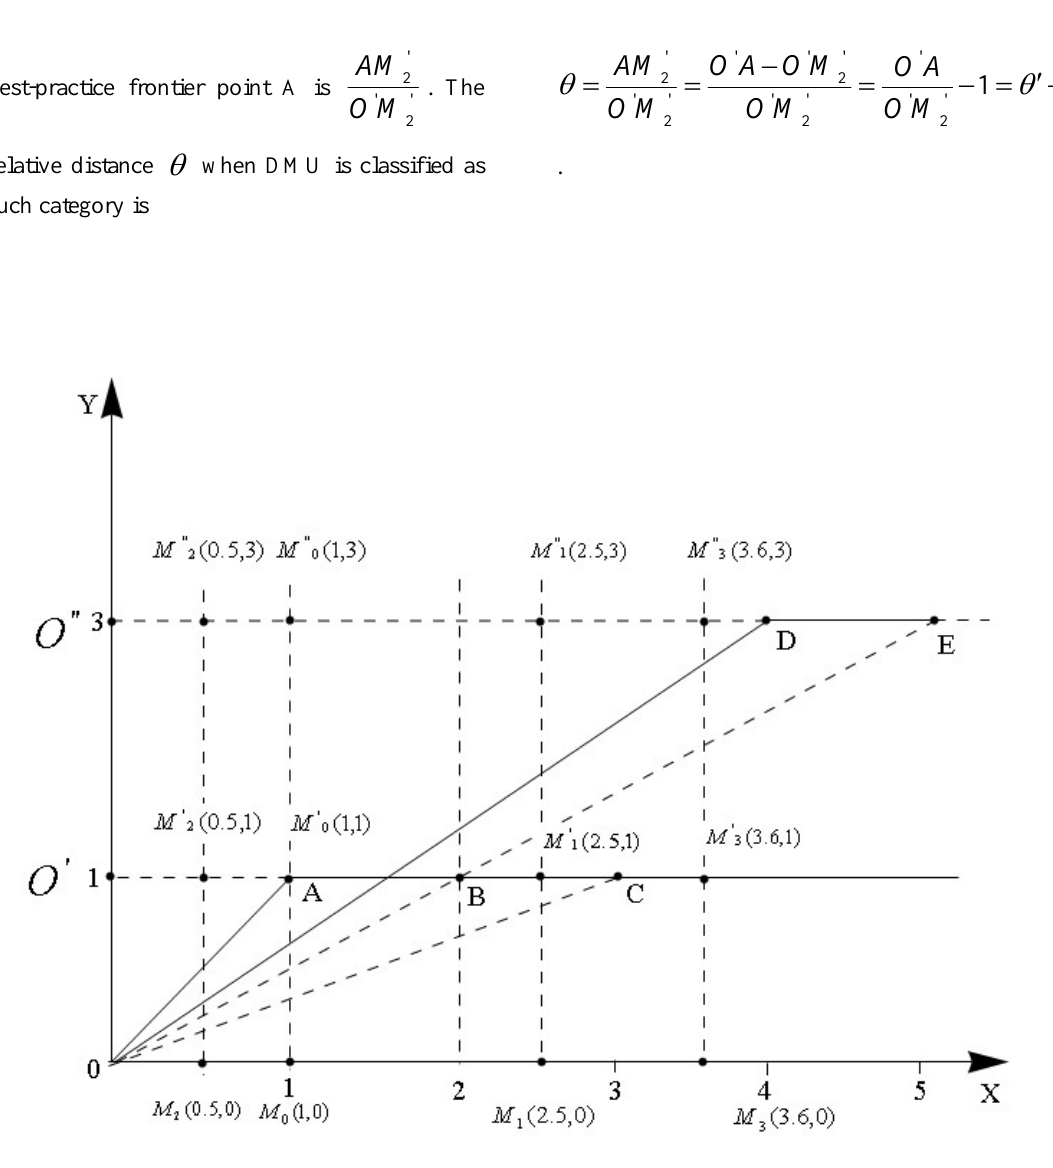
Fig. 4. Production frontier and analysis of various types of samples 1